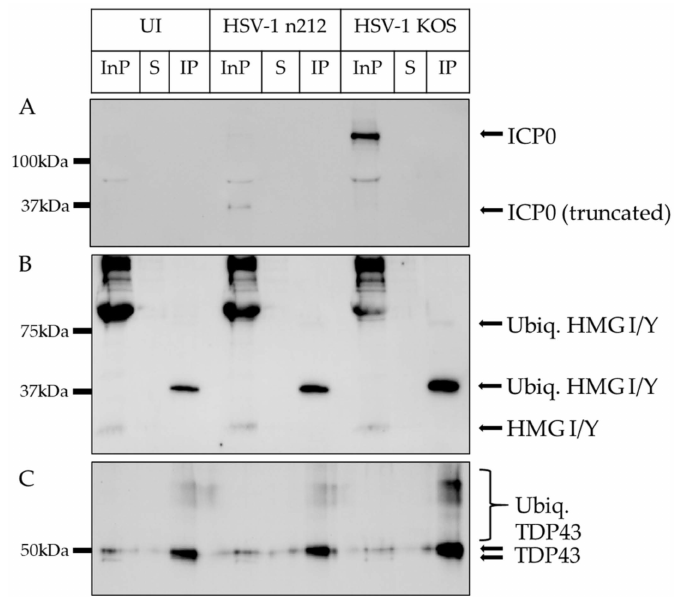
Figure 4. Ubiquitination of ICP0 ( A ), HMG I/Y ( B ), and TDP43 ( C ). Immunoprecipitation was conducted 8 hpi using Dynabeads conjugated to anti-FK2 antibodies that specifically targets K29, K48, K63, and mono-ubiquitinated proteins. Total protein input (InP), supernatant from immunopre- cipitation (S) and immunoprecipitated eluate (IP) from uninfected (UI), HSV-1 n 212-infected, and HSV-1 KOS-infected neurons were probed with antibodies targeting each protein of